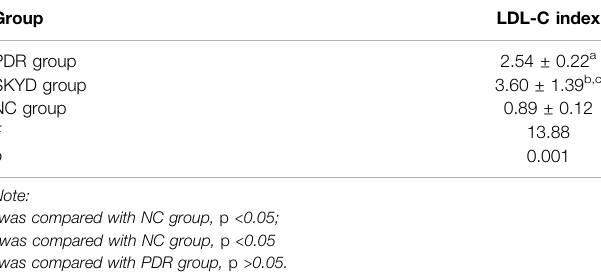
TABLE 4 | LDL-C index in three groups of mice (mean ± standard